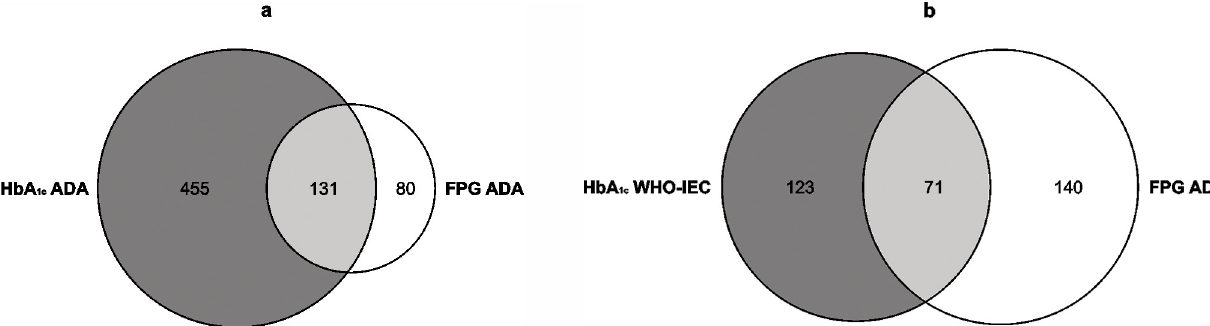
Fig 1. a and b. Levels of agreement between pre-diabetes classifications defined by HbA 1c or FPG. The figures show the levels of agreement between pre- diabetes classifications defined by HbA 1c or FPG for (a) HbA 1c ADA compared to FPG ADA and (b) HbA 1c WHO-IEC compared to FPG ADA.